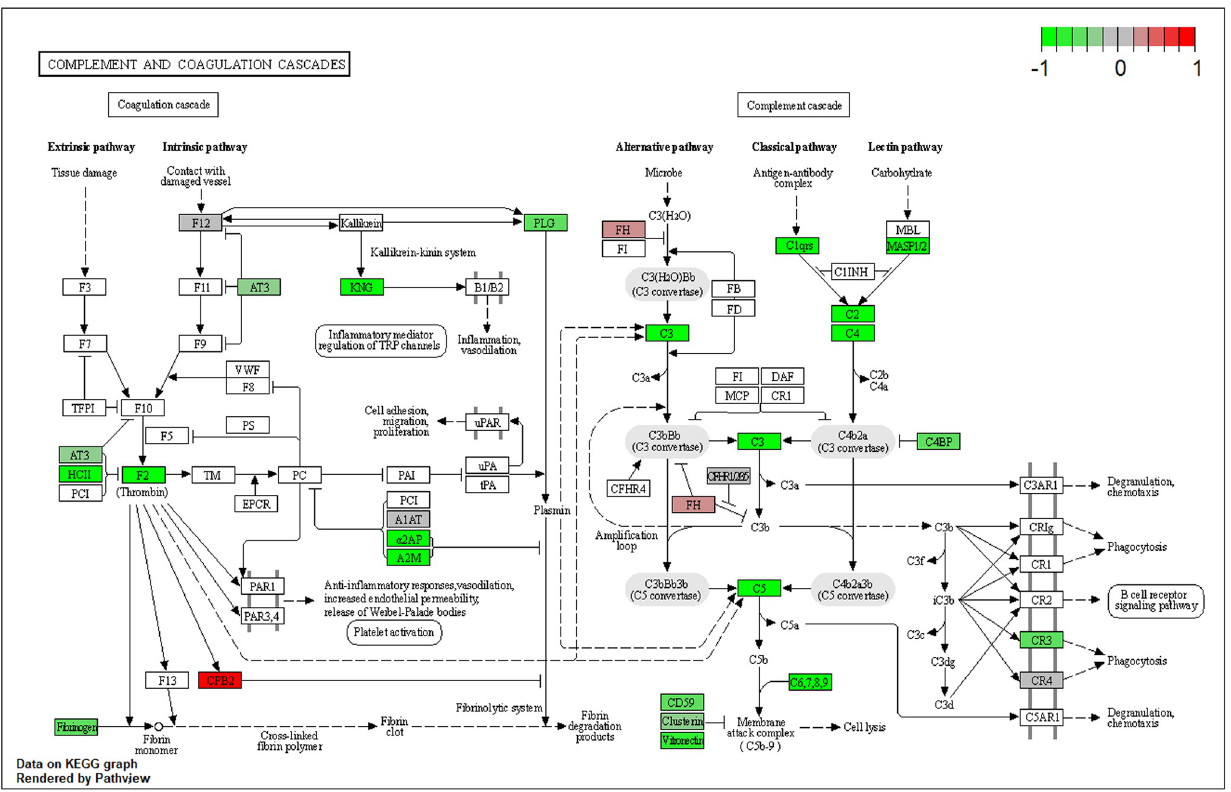
Fig 4. Proteins detected in this study that related to complement and coagulation cascade. Up-regulated proteins are highlighted in red and down- regulated proteins are highlighted in green.